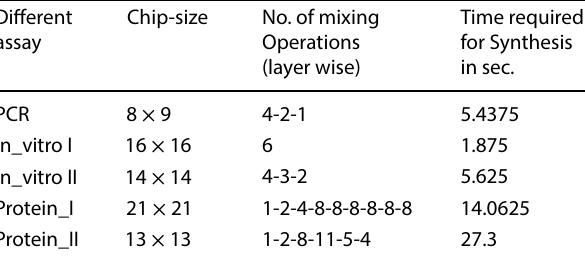
Table 10 Entire mixing completion time using RBS method for PCR and others benchmarks Different Chip-size assay